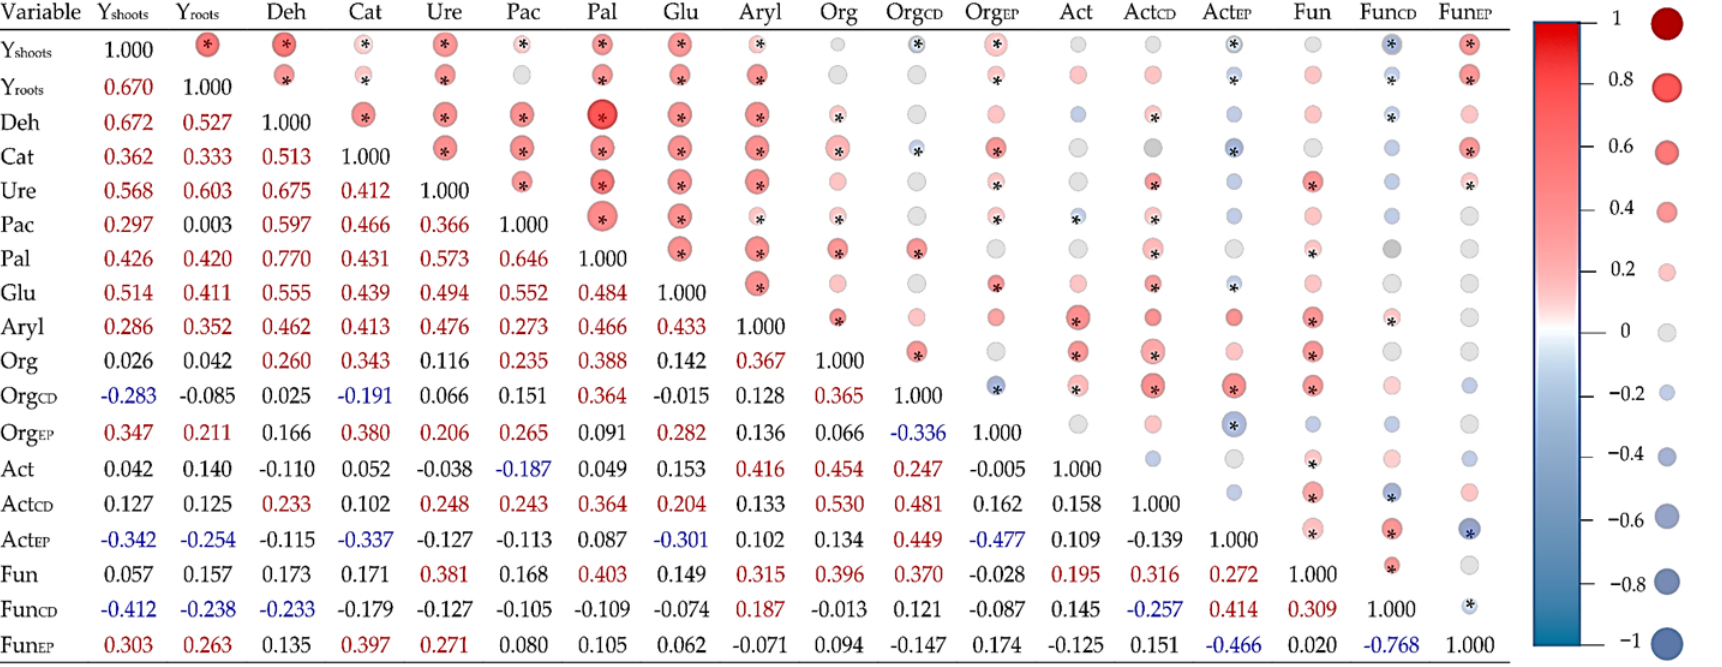
Figure 8. Pearson’s simple correlation coefficients, n = 112; Org—organotrophic bacteria; Act—actinomycetes; Fun—fungi; Deh—dehydrogenases; Cat—catalase; Pac—acid phosphatase; Pal—alkaline phosphatase; Glu— β -glucosidase; Aryl—arylsulphatase; Org—organotrophic bacteria; Act—actinomycetes; Fun—fungi; Y—yield of Helianthus annuus L.; CD—colony development index; EP—ecophysiological diversity index; * significant for p = 0.05.